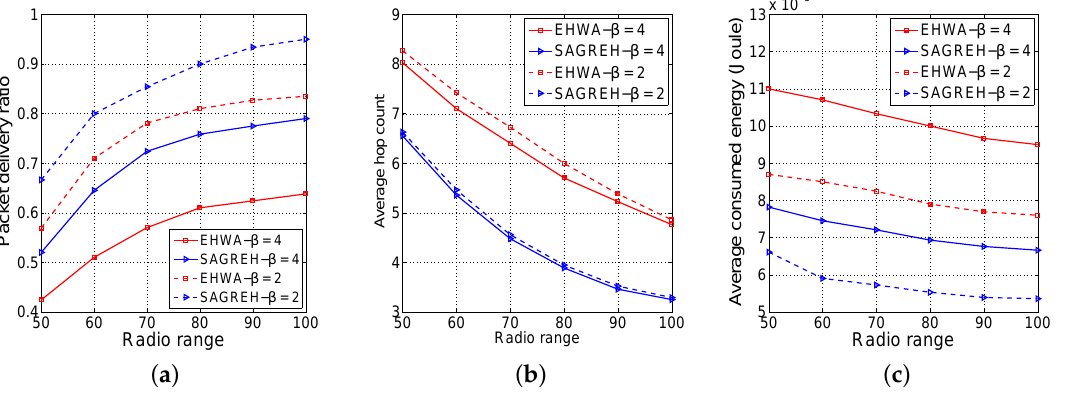
Figure 6. ( a ) The Packet delivery ratio (PDR), ( b ) average hop count, and ( c ) average energy consumption as functions of radio